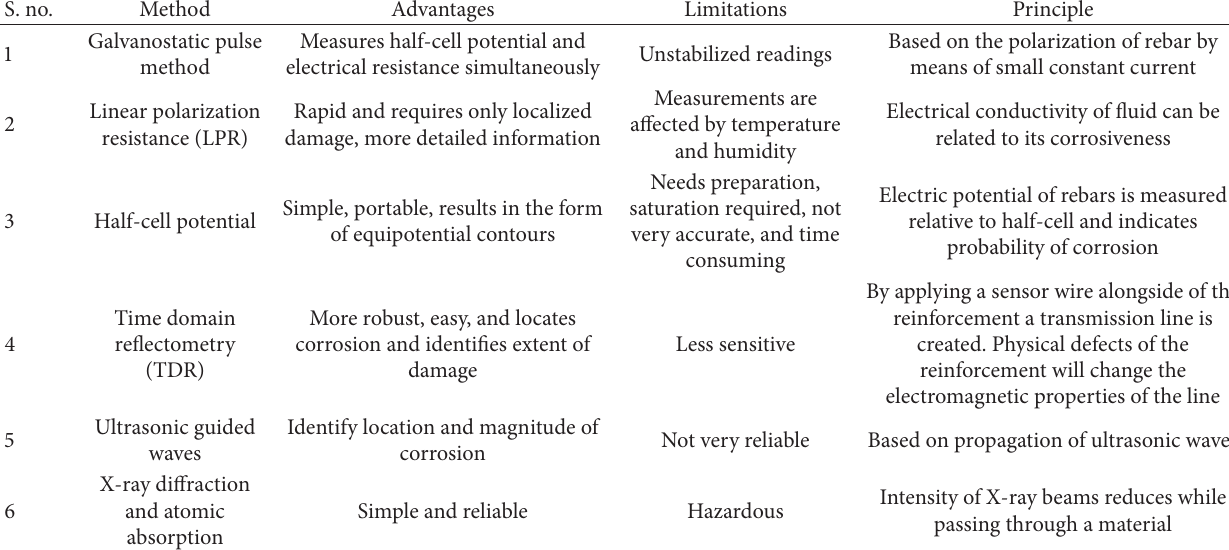
Table 1: Methods for evaluating corrosion in concrete structures [5].